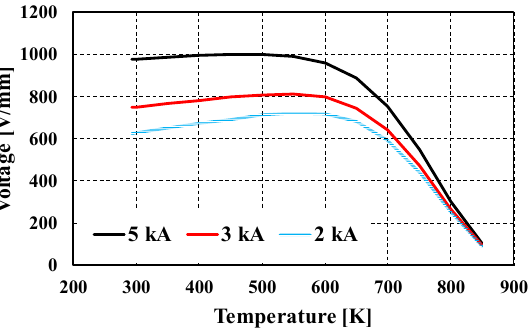
Figure 3. Temperature dependences of voltage per millimeter across the MOV element for impulse currents of 2, 3, and 5 kA.